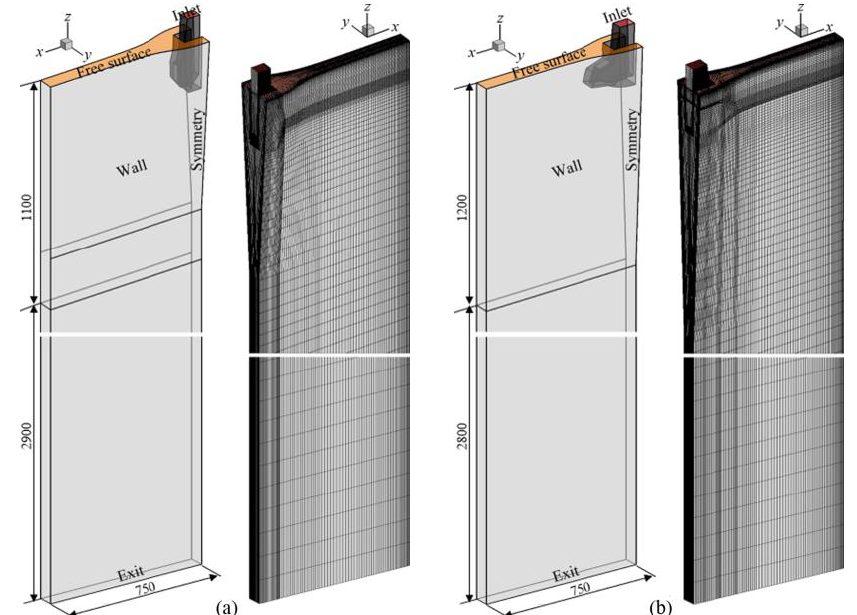
Figure 2. Schematic diagram of computational domain and mesh: ( a ) CSP mold and ( b ) FTSR mold.